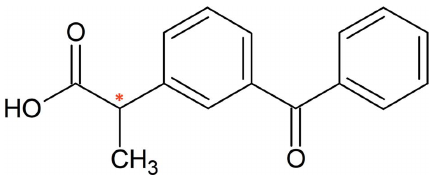
Figure 1 Chemical structure of ketoprofen; the chiral center is labeled with an